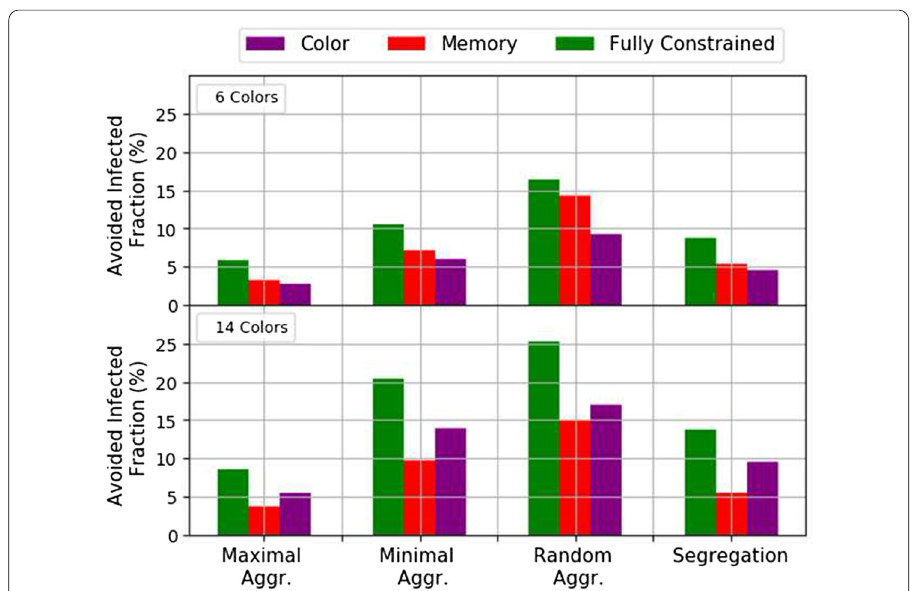
Fig. 7 Fraction of avoided infected agents considering different forms of social interactions compared to the scenario of no memory and not respecting the colors for the original network. Top panel: strategies are with N c = 6 ; bottom panel: N c = 14 . Error bars are not plotted for being